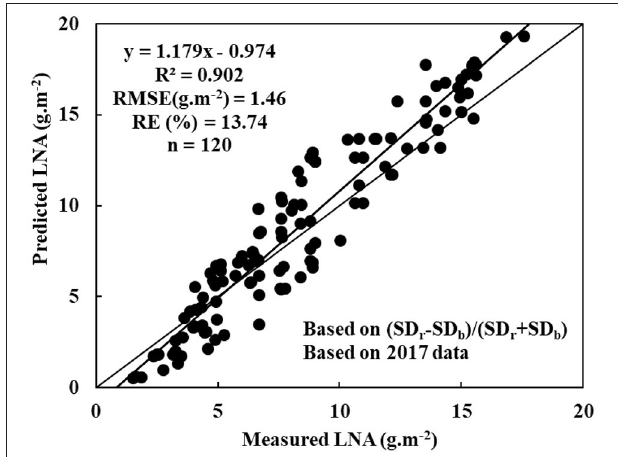
FIGURE 4 | Evaluating the diagnostic model based on (SD r − SD b )/(SD r +SD b ) using a different cultivar or even wheat grown elsewhere: y = 1.179x - 0.974, R 2 = 0.902, RMSE (mg.g − 1 ) = 1.46, RE(%) = 13.74, n =